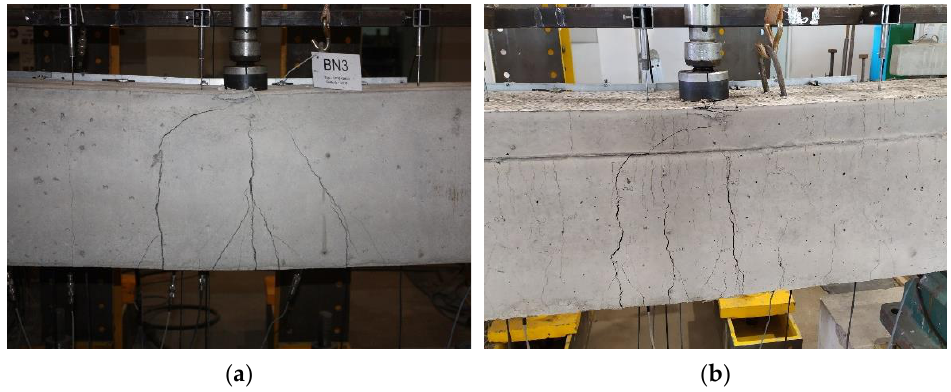
Figure 10. Failure observed at the mid-span zone in BN2 beam ( a ) and BL2 beam ( b ).